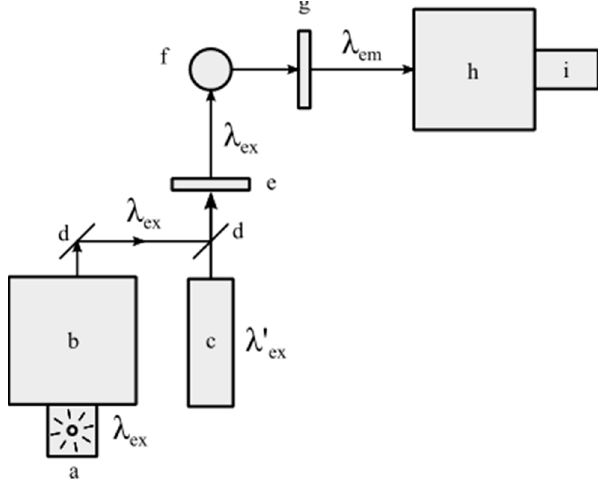
Figure 6. Luminescence spectrophotometer system set up for temperature measurement: ( a ) broad band excitation light source (e.g., Xe arc lamp); ( b ) excitation monochromator; ( c ) alternate laser excitation source; ( d ) 45° mirrors; ( e ) excitation filters and/or polarizers; ( f ) sample at temperature T; ( g ) emission filters and/or polarizers; ( h ) emission monochromator; ( i ) emitted light detector (e.g., photomultiplier tube or CCD camera).